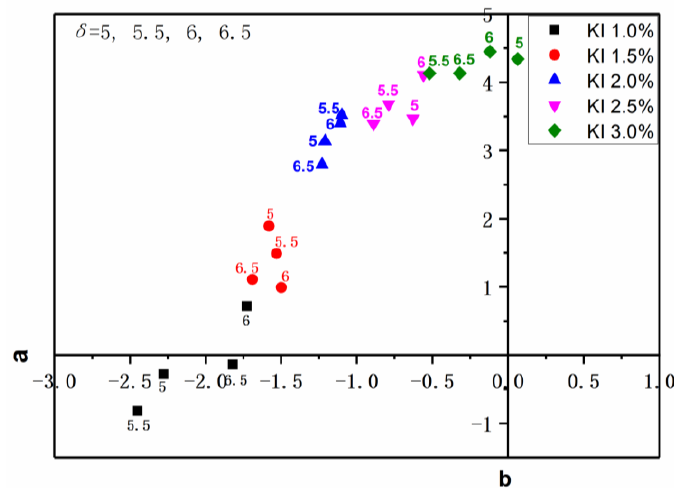
Figure 3. Coordinate system of chromaticity a and b values of PVA polarizing films prepared in the correcting tank with the concentration of KI being set to 1.0%, 1.5%, 2.0%, 2.5% and 3.0% respec- tively.